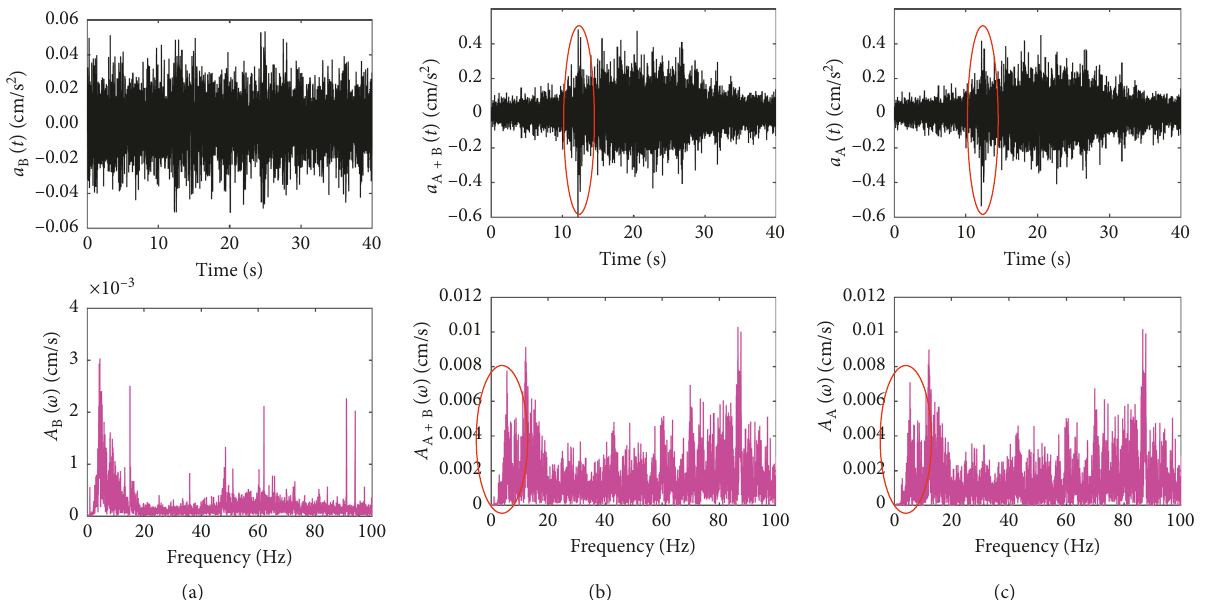
Figure 5: Signal comparison of background vibration, overall vibration, and subway-induced vibration. (a) Background vibration. (b) Overall vibration. (c) Subway-induced